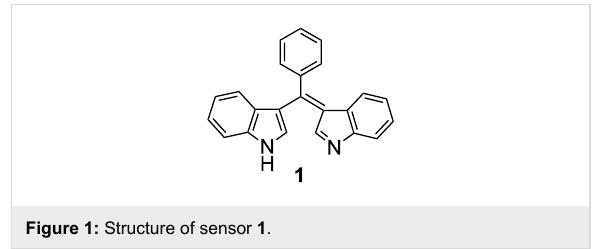
Figure 1: Structure of sensor 1